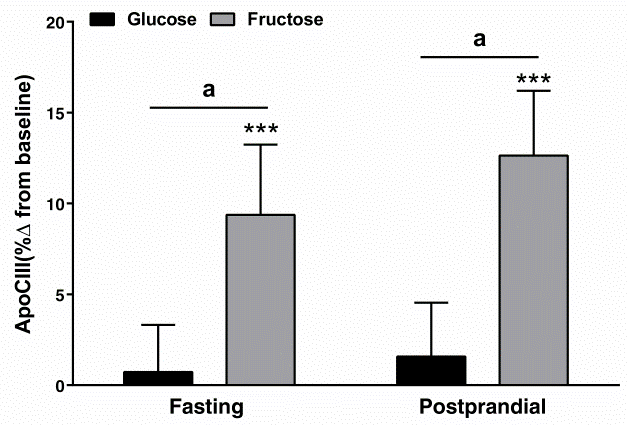
Figure 2. Percent (%) changes (10 weeks vs. 0 weeks) of apoCIII in the serum of subjects consuming glucose ‐ ( n = 15) or fructose ‐ sweetened beverages ( n = 16) for 10 weeks. a p < 0.05 effect of sugar, least squares (LS) means different from zero; *** p < 0.001, LS means different from zero—change from baseline. Data shown as mean ± SEM.